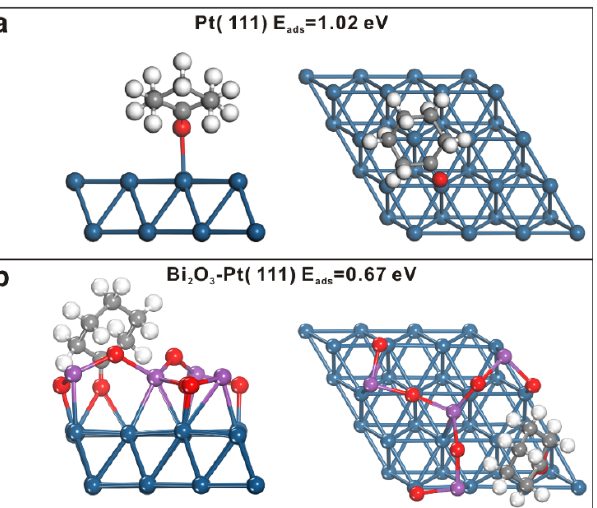
Figure 1. Calculated structures and the adsorption energies of the cyclohexanone on ( a ) Pt(111) and ( b ) Bi 2 O 3 modified Pt(111). Pt, Bi, C, O, and H atoms are in blue, purple, gray, red, and white, respectively. The results of Pt(111) is consistent with our previous work and is reproduced with permission from [13]. Copyright 2018, Wiley-VCH.